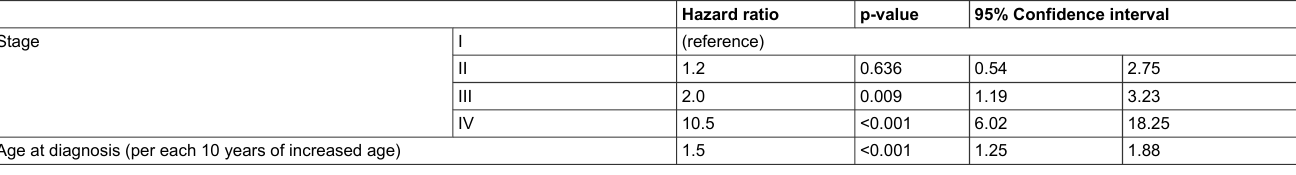
Table 5: Cox regression results, best model. Overall